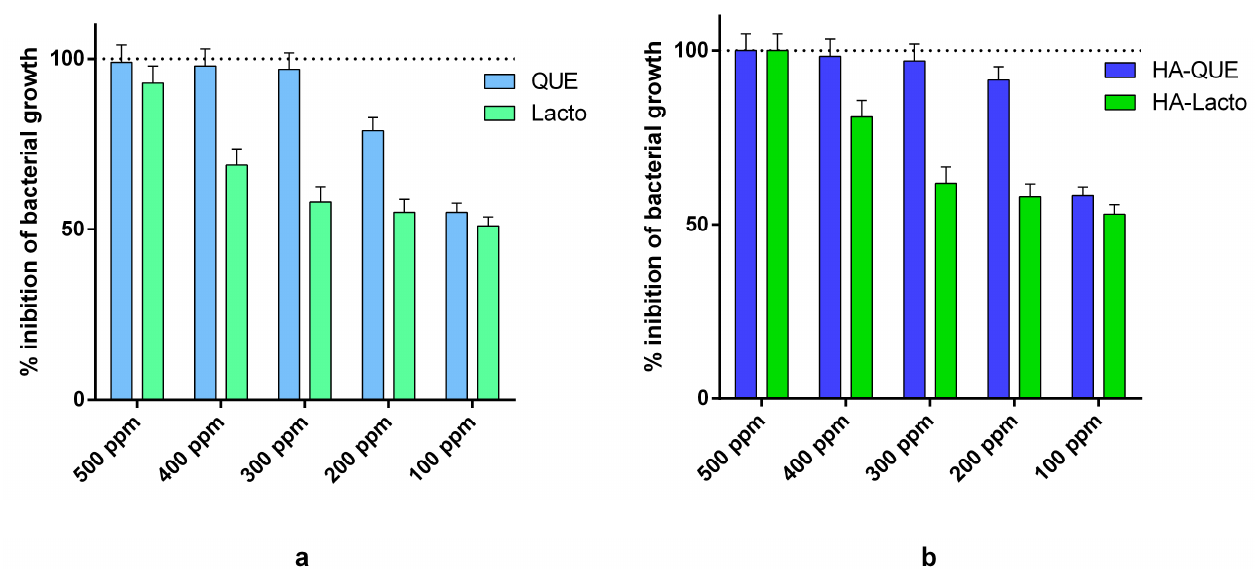
Figure 1. ( a ) Antimicrobial activity at different concentrations of Que and Lacto against Pseudomonas fluorescens (10 6 CFU/mL). ( b ) Antimicrobial activity at different concentrations of HA–Que and HA–Lacto against Pseudomonas fluorescens (10 6 CFU/mL).